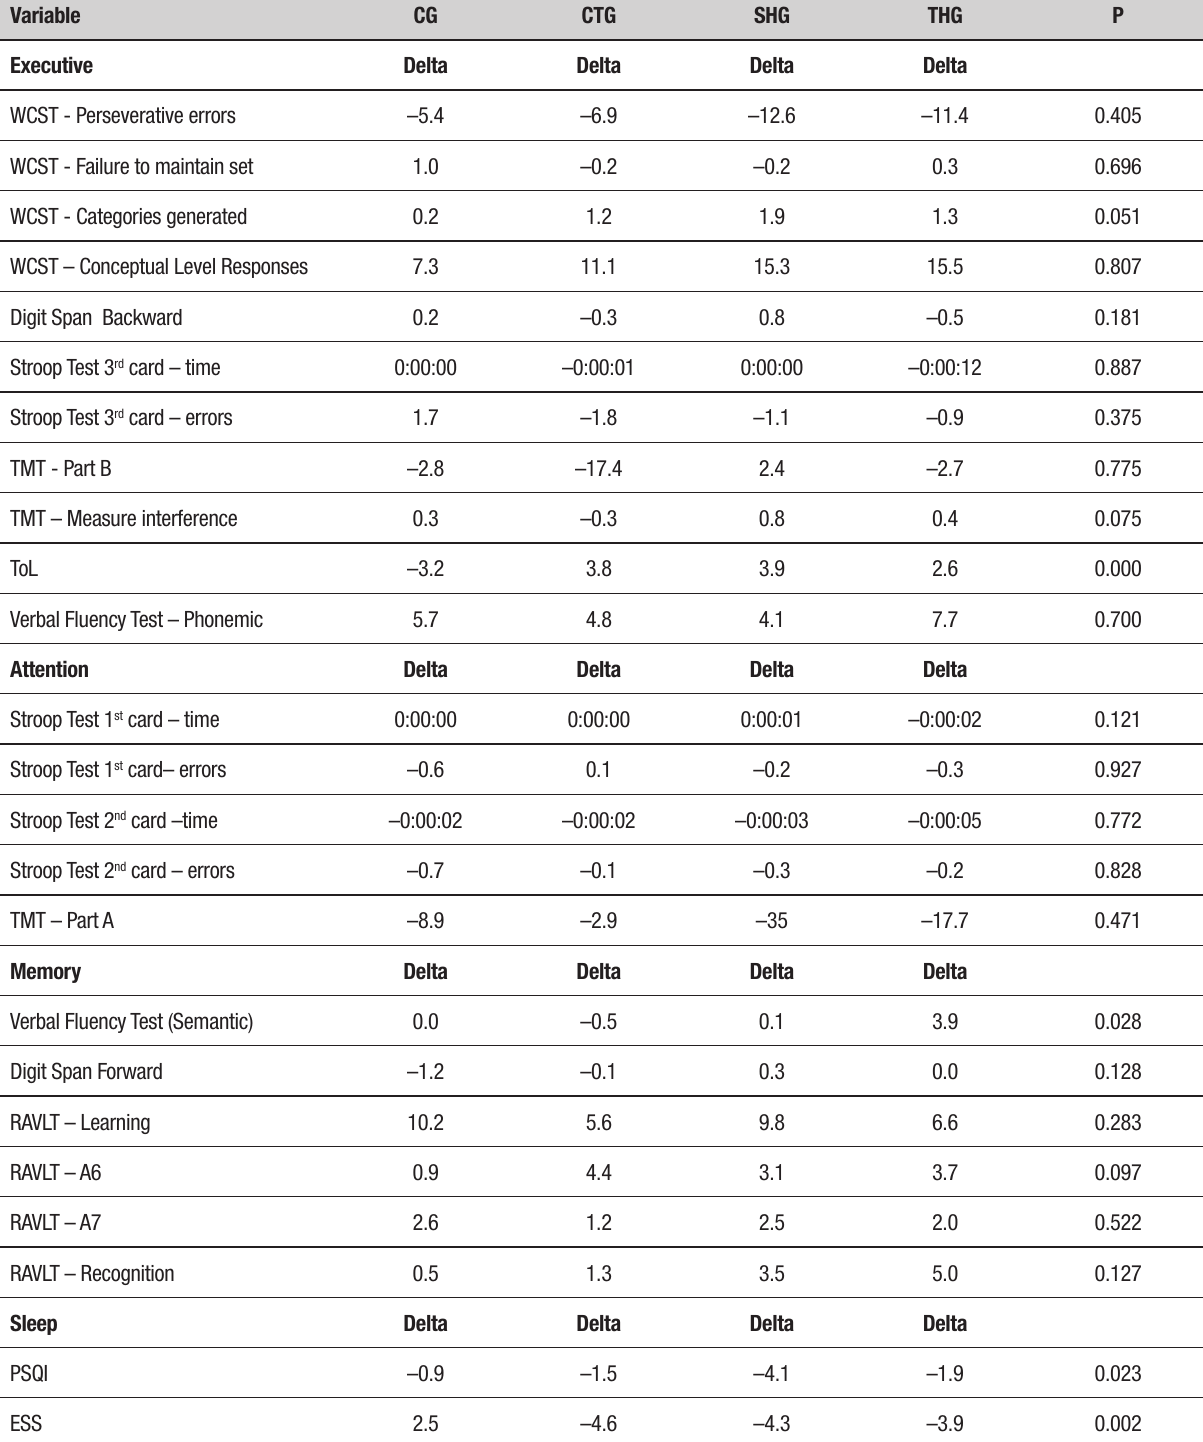
Table 3. Comparison between interventions* – Sleep and cognitive